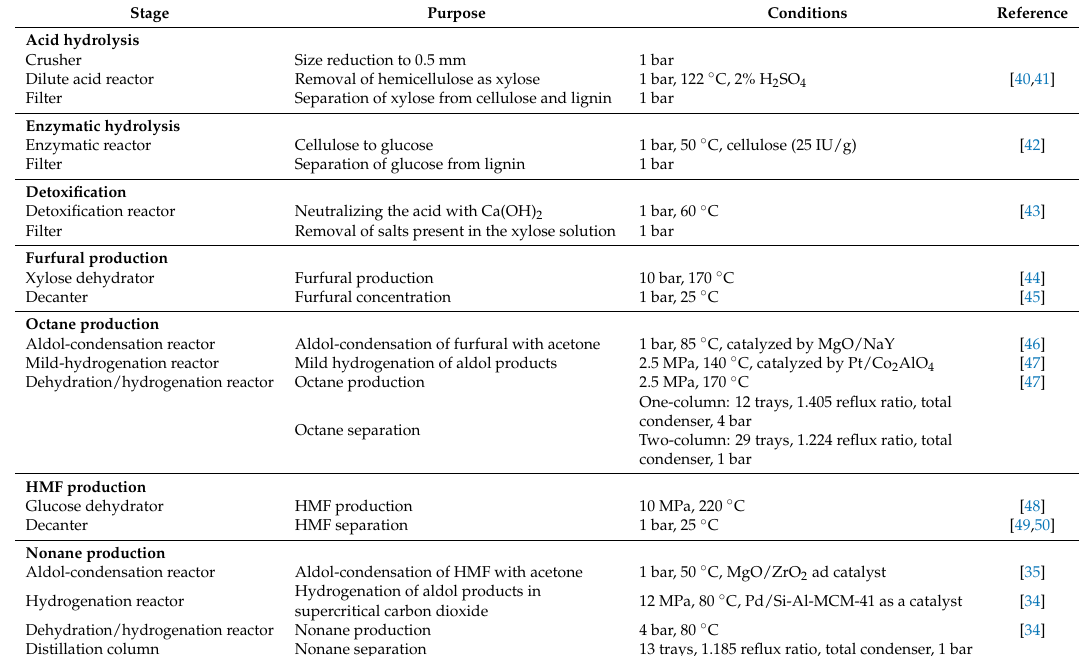
Table 2. Conditions and main equipment used in each processing stage.